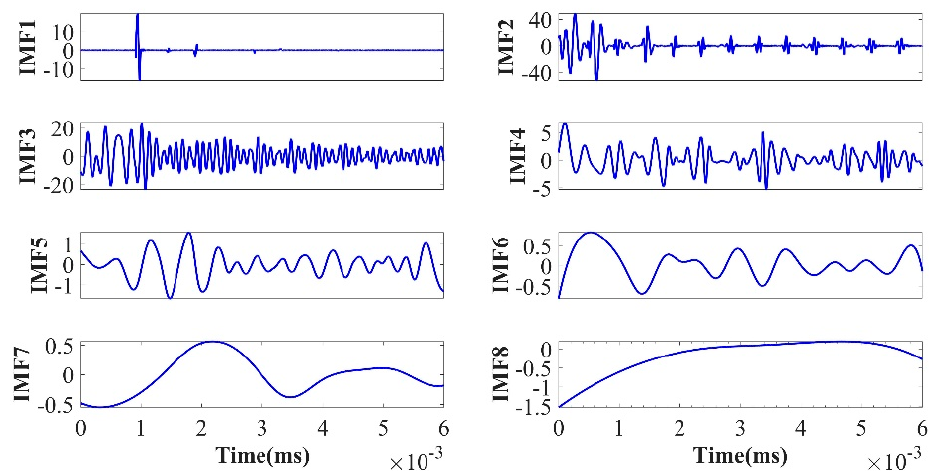
Figure 8. CEEMD decomposition results of mg1-0 raw data. Table 2. The cross-correlation coefficient between each IMF and the original signal and their respective energy ratios.